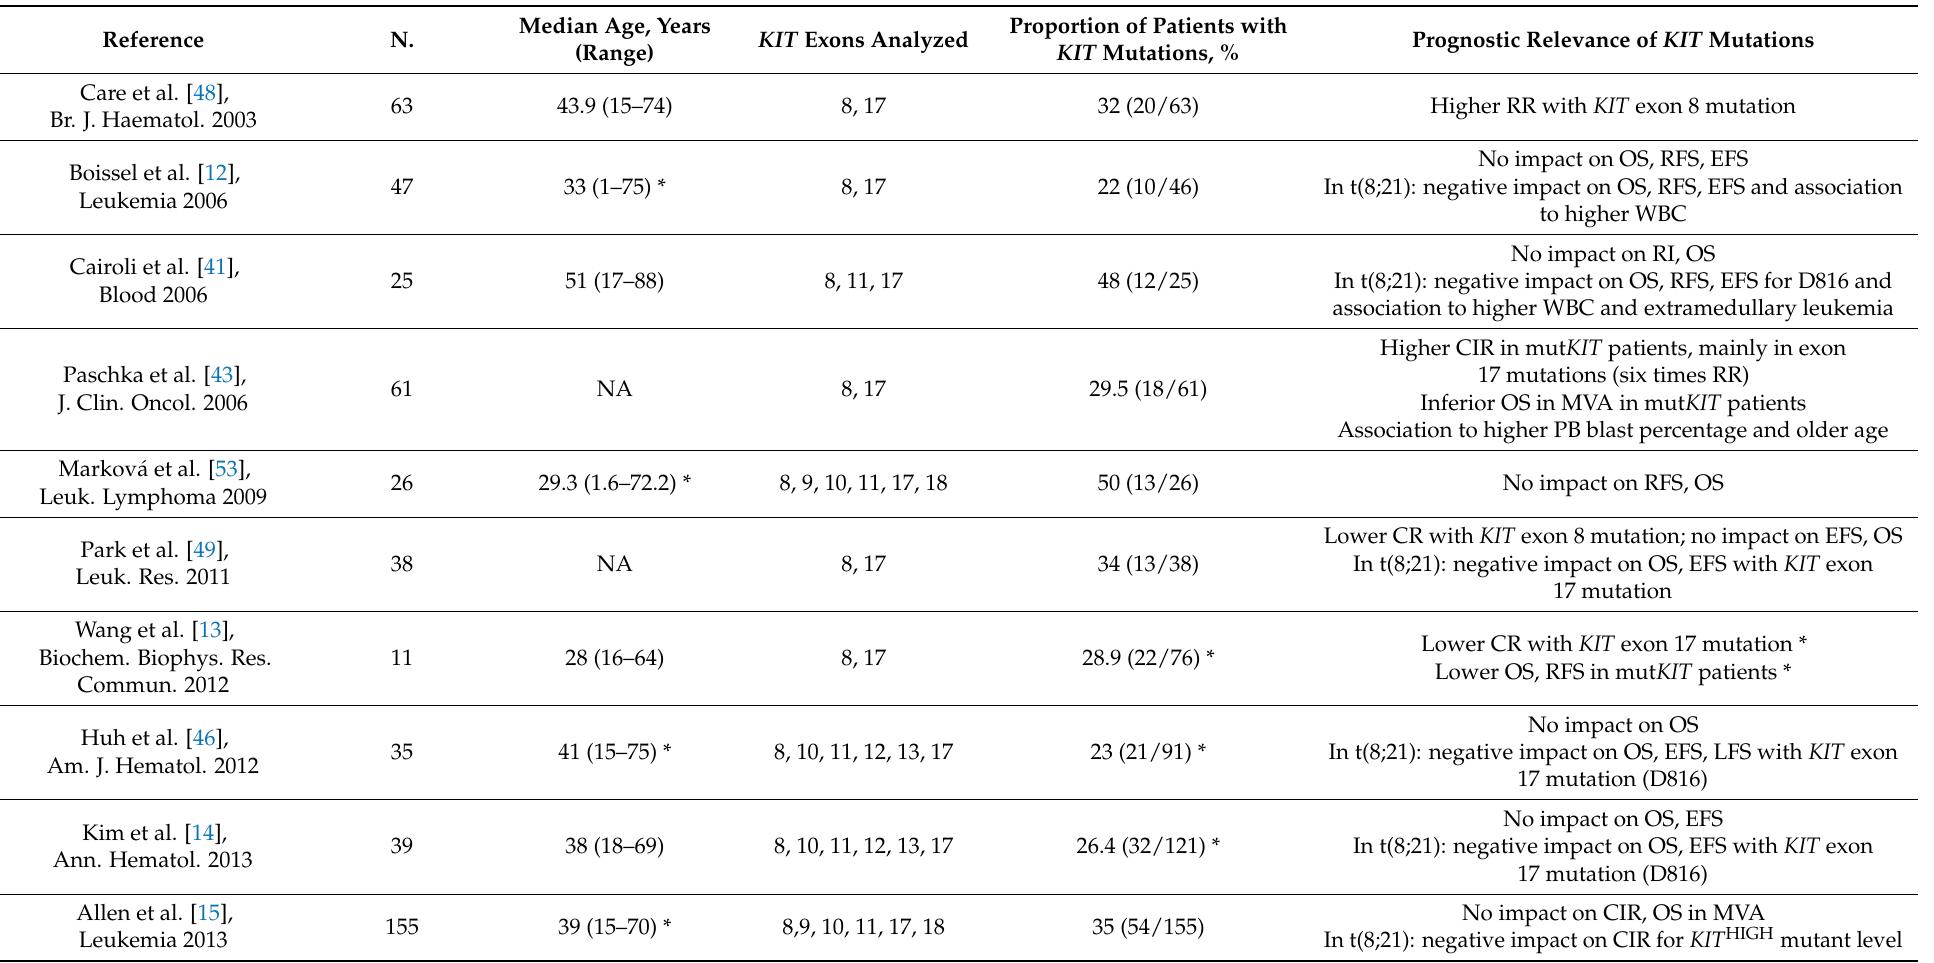
Table 2. Prognostic relevance of KIT gene mutation in AML positive for